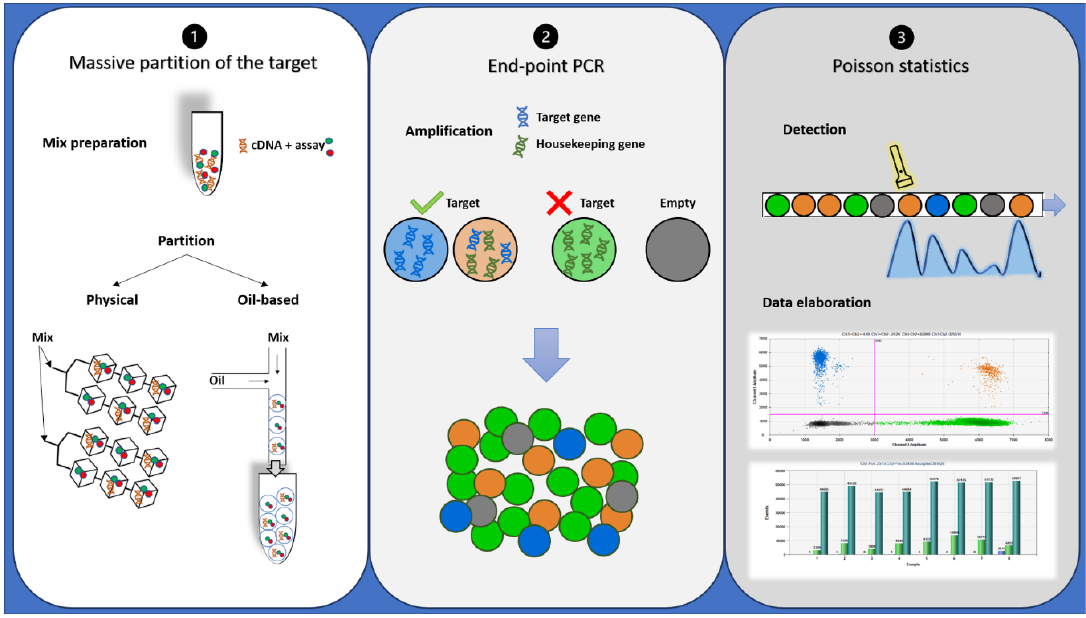
Figure 2. Description of droplet PCR workflow: ( 1 ) PCR reaction mixtures for each sample were partitioned in a microfluidic chip or through an oil-based emulsion. ( 2 ) The partitioned samples were placed into a standard thermal cycler for end-point PCR amplification: In the droplets containing target cDNA, the specific probe hydrolysis occurs and bright fluorescence appears, while in the droplets containing no target molecules (empty), only background probe fluorescence results. ( 3 ) Each droplet’s fluorescence was detected and processed into a two-dimensional scatter plot display. The number of droplets within each gate was then counted.